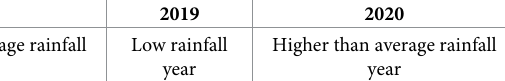
the soil center (cm), R is the distance between the centrifuge rotor axis and the bottom of the 2 soil sample (cm), ρ is the water density (g/cm 3 ), g is the acceleration of gravity (cm/s 2 ), and ω w is the angular velocity (rad/s).